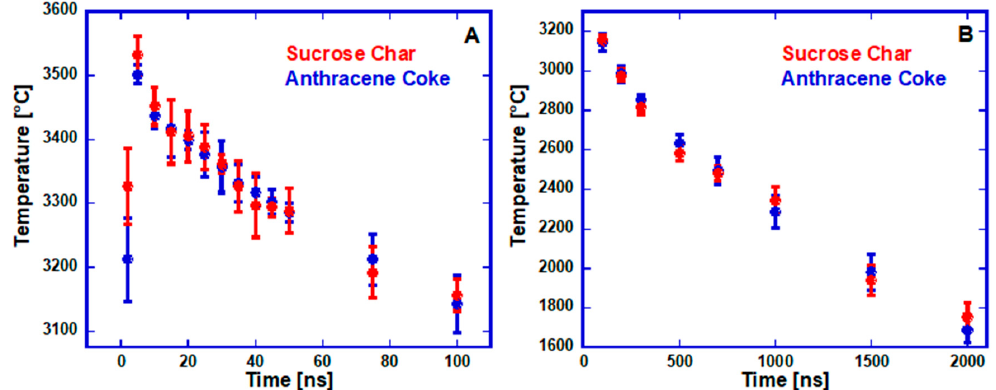
Figure A6. ( A ) EDS map ( B , C ) TEM micrographs of sucrose char—200 mJ/cm 2 . C 2018 , 4 , x FOR PEER REVIEW